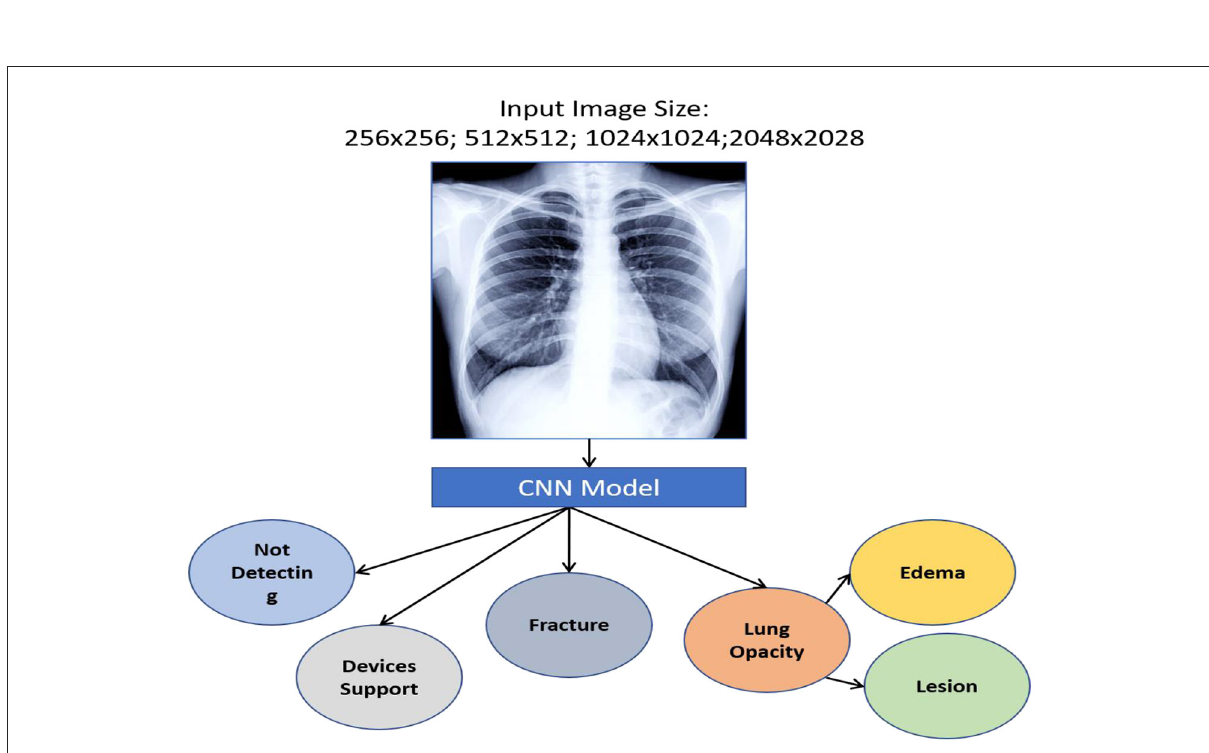
FIGURE9 Workflow of CNN-based